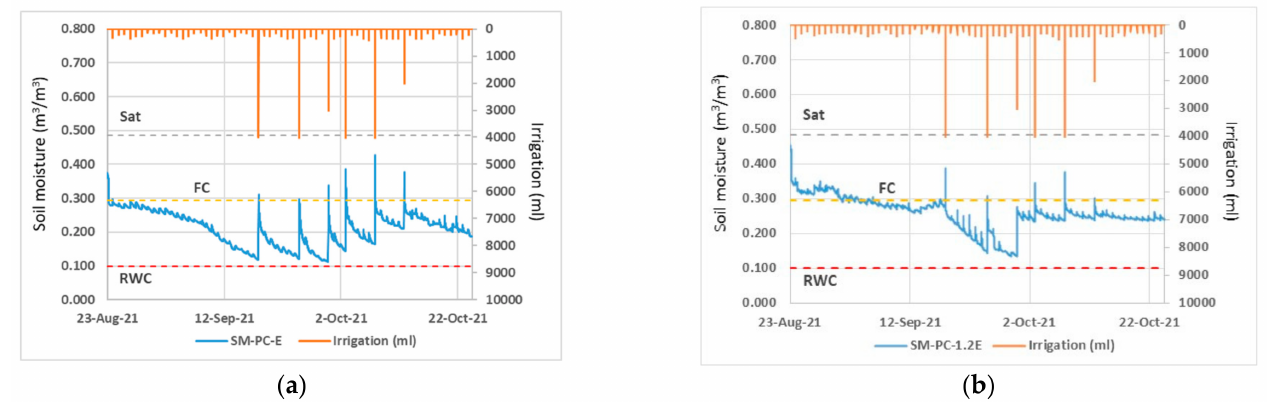
Figure 10. The fluctuation in soil moisture and irrigation: ( a ) PC-E treatment, ( b ) PC-1.2E treatment.